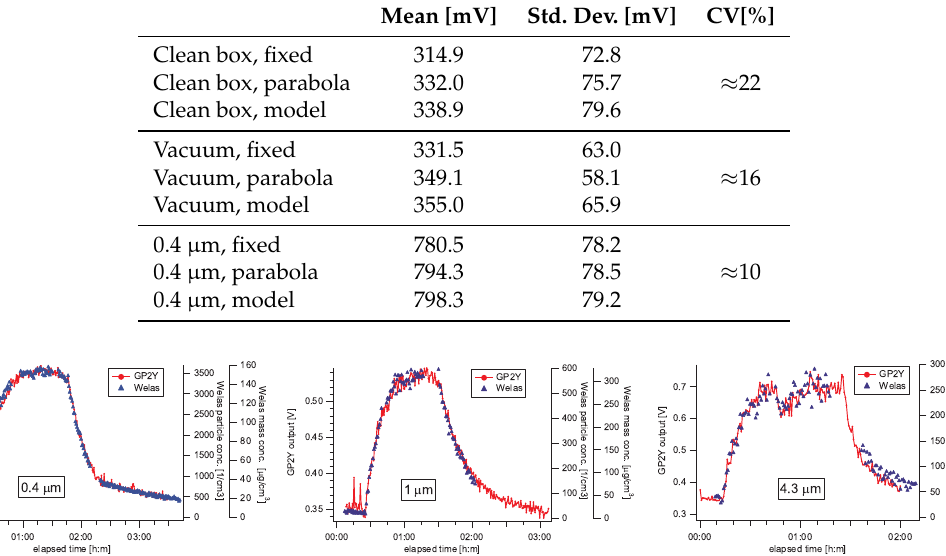
Figure 7. GP2Y sensor response (red, circles, left axis) to a known test aerosol compared to Welas particle number concentration measurement (blue, triangles, right axis) for different monosized atmospheres. Each datapoint represents the average of a 50 s time window (i.e., 500 pulses for